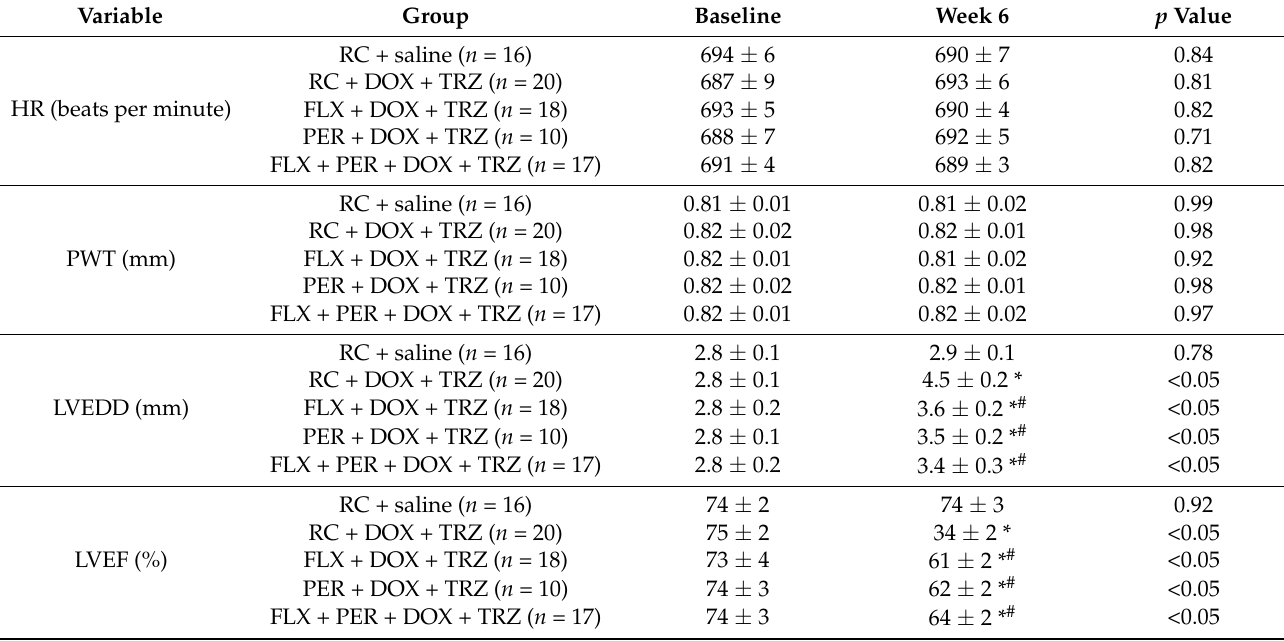
Table 1. Echocardiographic parameters at baseline and 6